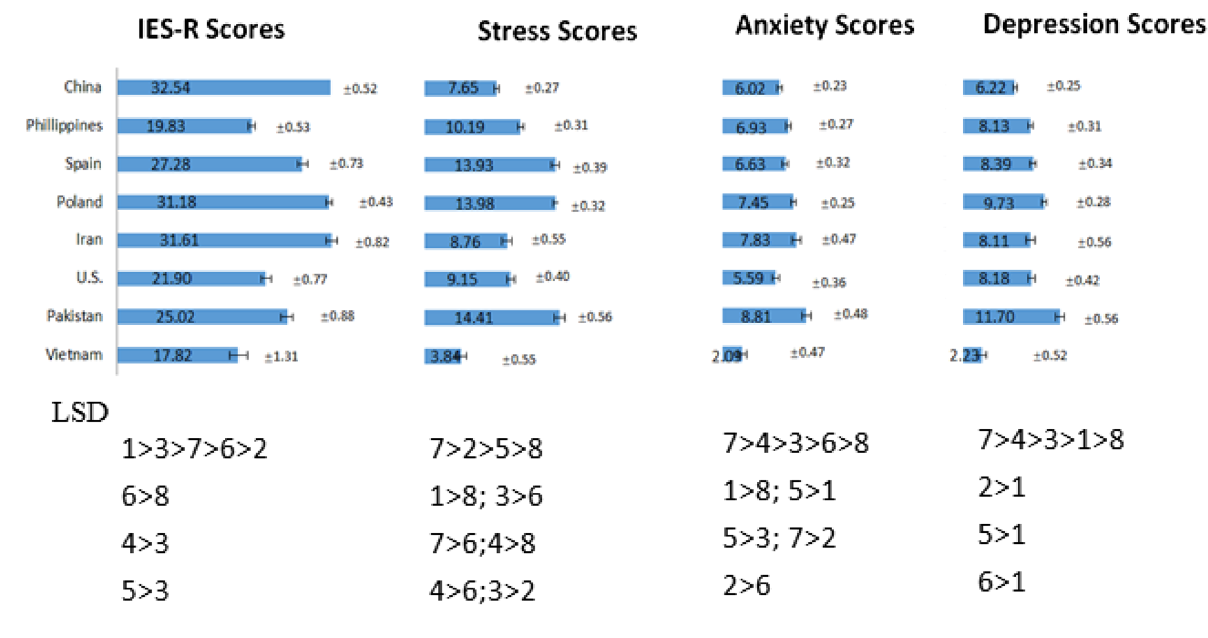
Figure 2. Comparison of Impact of Event Scale (Revised) IES-R and Depression, Anxiety and Stress Scale- 21 (DASS-21) scores among 8 countries based on the least significant difference (LSD) analysis. 1 =